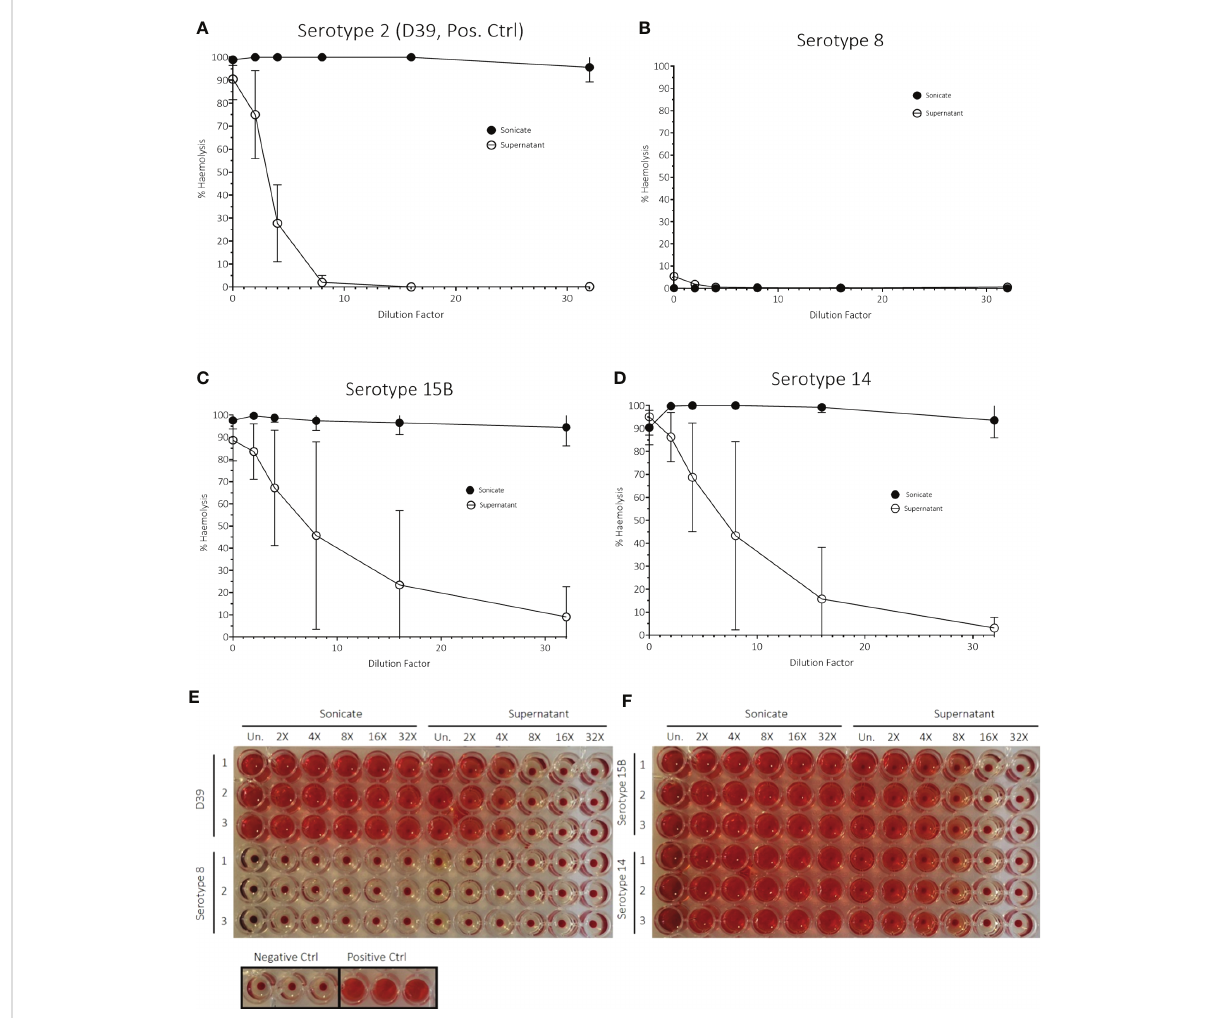
FIGURE 6 Haemolytic activity assay with human blood of (A) D39, serotype 2 (positive bacteria control) and strains used in in vivo experiments of (B) serotype 8, (C) serotype 15B and (D) serotype 14. The data represent three independent experiments (n = 3 replicates, mean ± sd). The assay was carried out with both sonicated bacteria (= sonicate) and the supernatant of bacterial cultures in brain-heart infusion broth (BHI) (= supernatant). dH 2 O water was used as a positive control. Phosphate buffered saline (PBS, pH = 7.0) was used as a negative control. Images (E, F) show results of the haemolysis experiment after centrifugation. All experiments were performed in triplicates (1, 2, 3). rows: from left to right: dilution from undiluted sample (Un.) is